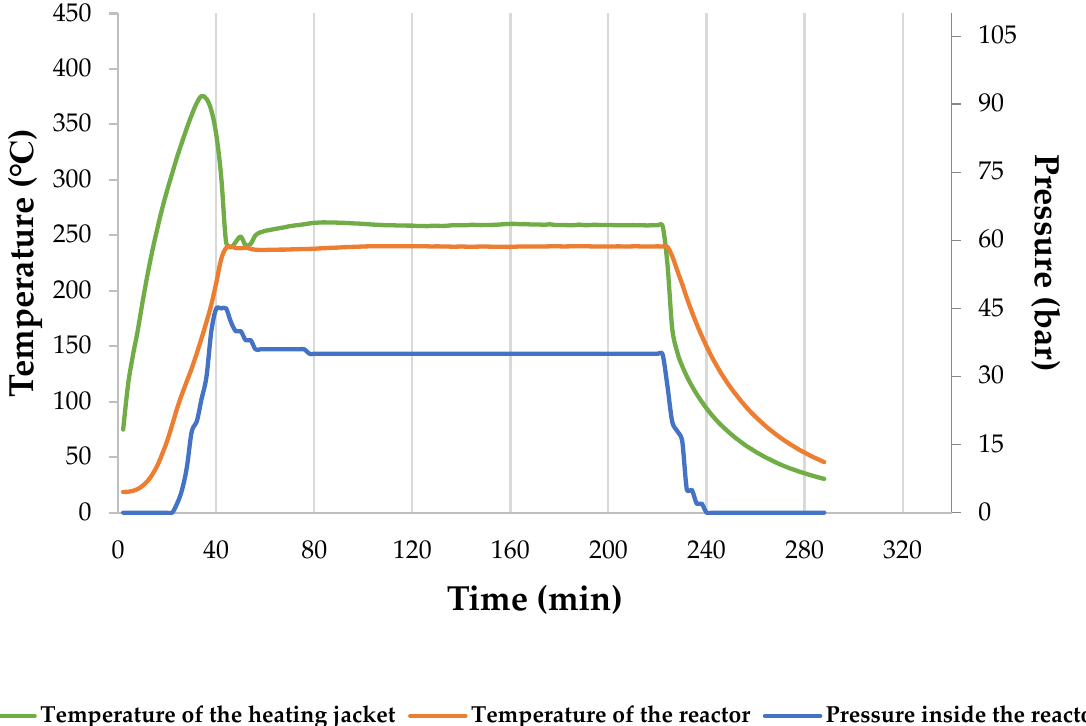
Figure A4. Temperature and pressure patterns during the process at 240 ◦ C in 30 min.